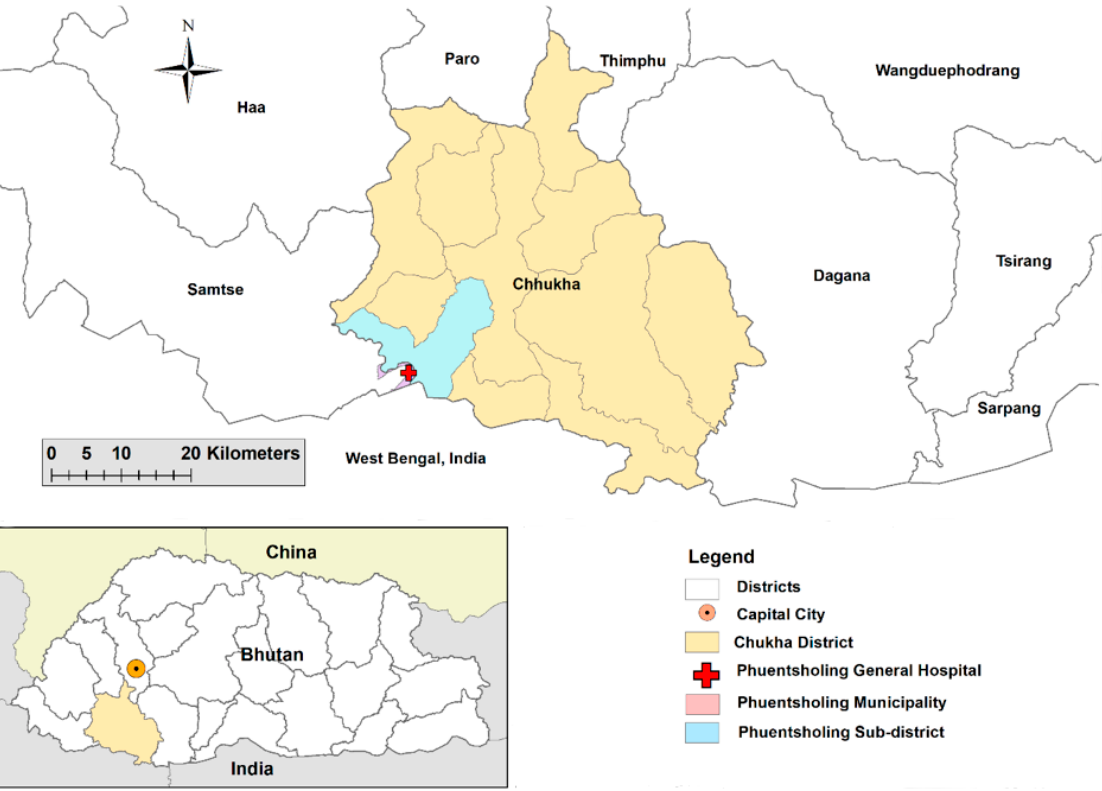
Figure 1. Map of Phuentsholing Hospital, Chhukha, Bhutan